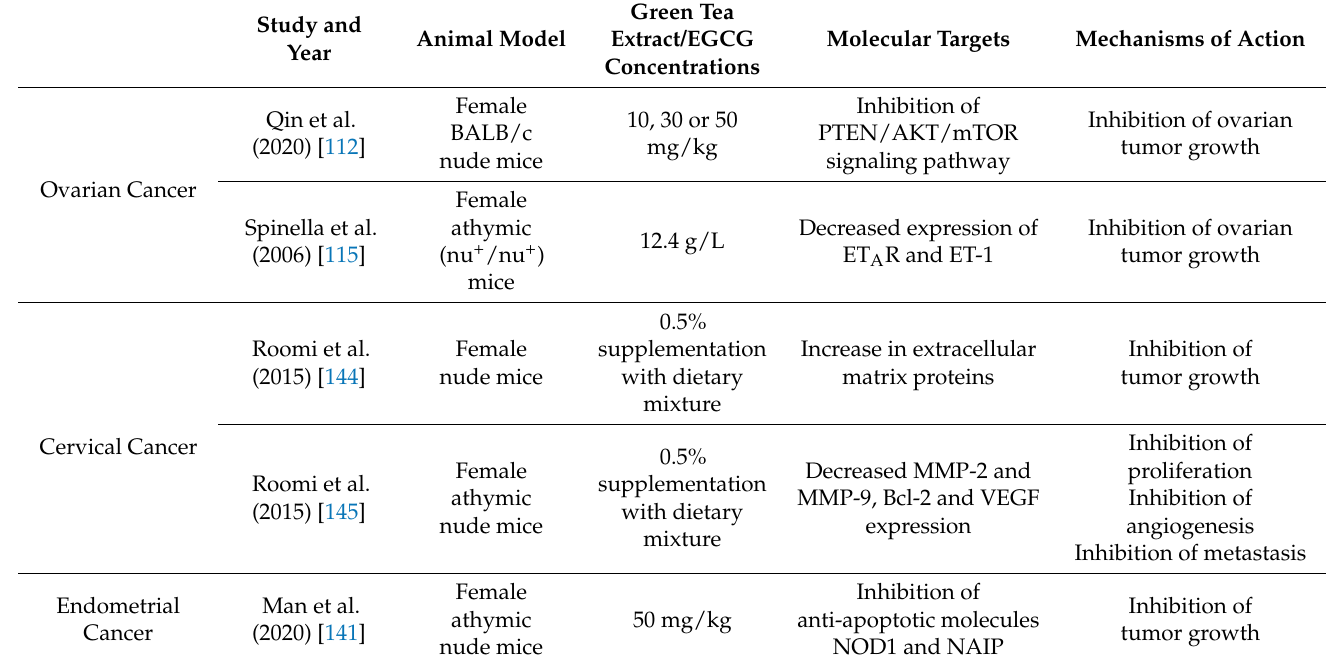
Table 2. In vivo studies examining the effect of green tea on reproductive cancers.